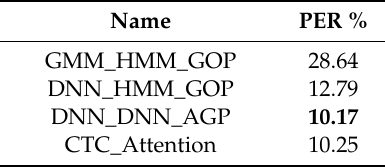
Table 8. Performance of ASR systems with di ff erent model architectures.